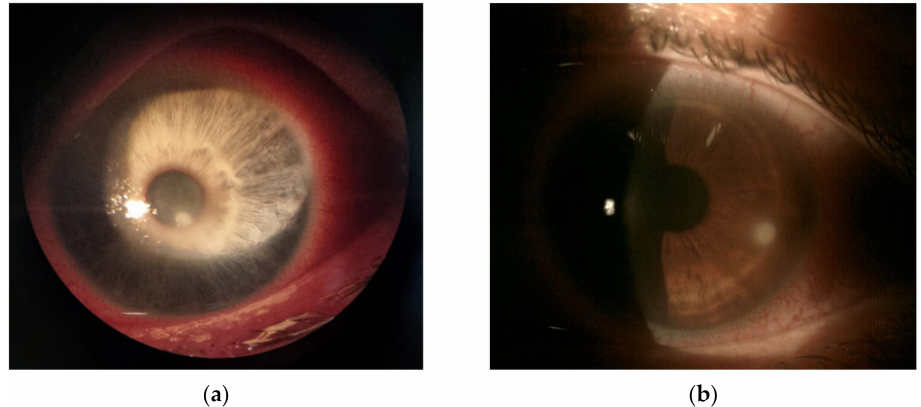
Figure 1. ( a ) An early corneal infiltrate with confirmed etiology of Stenotrophomonas maltophilia ; ( b ) an early corneal infiltrate with confirmed etiology of Fusarium